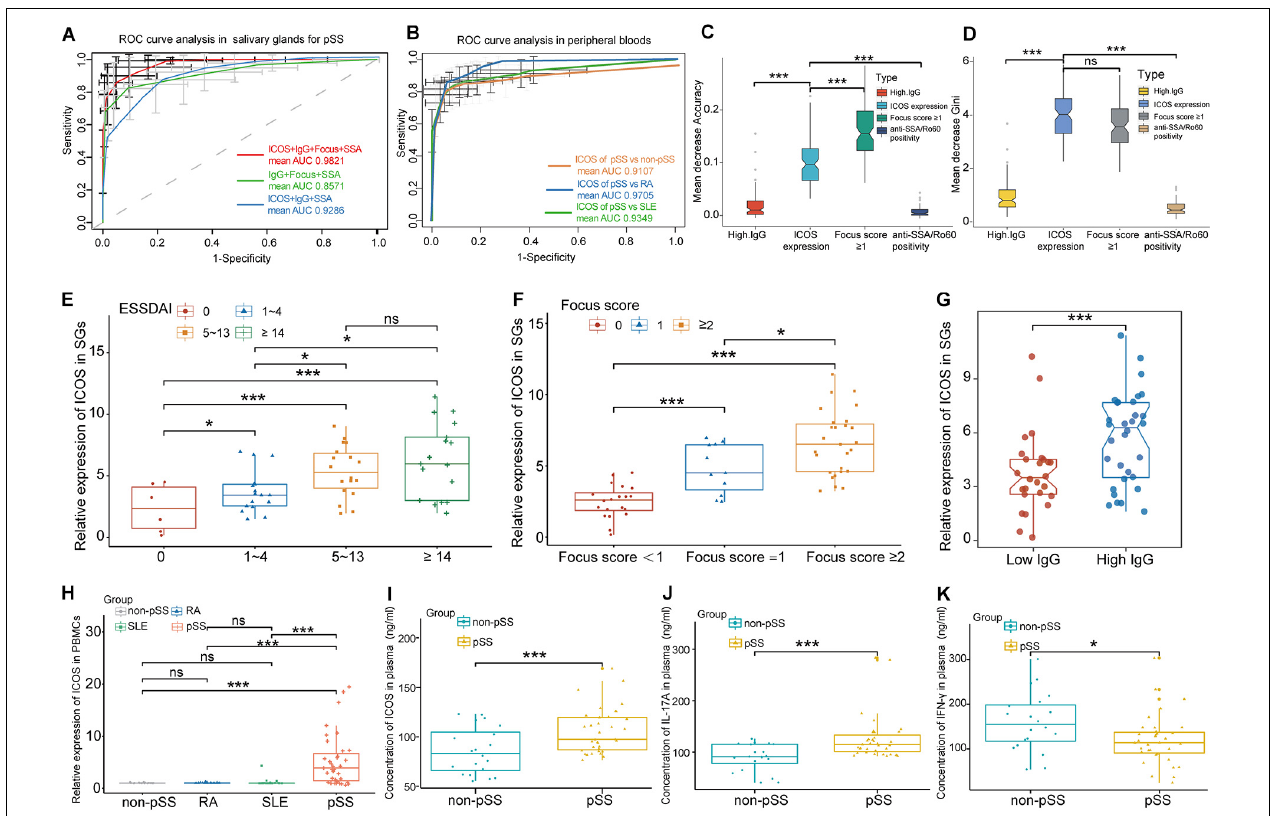
FIGURE 6 | ICOS combined with traditional clinical indices for the diagnosis of primary Sjögren’s syndrome (pSS), clinical interaction analysis of ICOS , and experimental validation of ICOS . (A) Receiver operating characteristic curve of pSS prediction for the random forest (RF) model in salivary glands (SGs). The green lines indicate the diagnostic capacity of clinical indices without ICOS [are under the curve (AUC) 0.8571], the red lines indicate the diagnostic capacity of the model combining clinical indices and ICOS (AUC 0.9821), and the blue lines indicated the diagnostic capacity of the model clinical indices and ICOS without positive pathology (focus score ≥ 1). (B) ROC curve of pSS prediction for the RF model in peripheral blood using RT-qPCR. The orange lines indicate the diagnostic capacity of ICOS in peripheral blood for pSS vs. non-pSS with a high mean AUC value of 0.9107. The blue line and the green line, respectively, indicate the significant diagnostic capacity of ICOS in peripheral blood of pSS from rheumatoid arthritis (RA) (AUC 0.9705) and systemic lupus erythematosus (SLE) (AUC 0.9349). (C,D) Variable importance of ICOS and clinical variables of predicting pSS in salivary glands. Mean decrease accuracy represents the decrease of accuracy in the model when one variable is excluded, and mean decrease Gini represents the specific diagnostic capabilities of variables in the construction of the predicting model. (E–G) Violin plots showing the expression levels of ICOS in different subgroups based on ESSDAI scores (E) , focus scores (F) , and high IgG levels (G) in SGs. (H) The expression of ICOS on the aspect of gene was validated via RT-qPCR in the peripheral blood samples of non-pSS, RA, SLE, and pSS. (I) The expression of ICOS on the aspect of protein was validated via ELISA in peripheral blood samples of pSS. (J,K) Elevated IL-17A and decreased IFN- γ expressions in pSS were confirmed through ELISA experiment. * p < 0.05; ** p < 0.01; *** p <